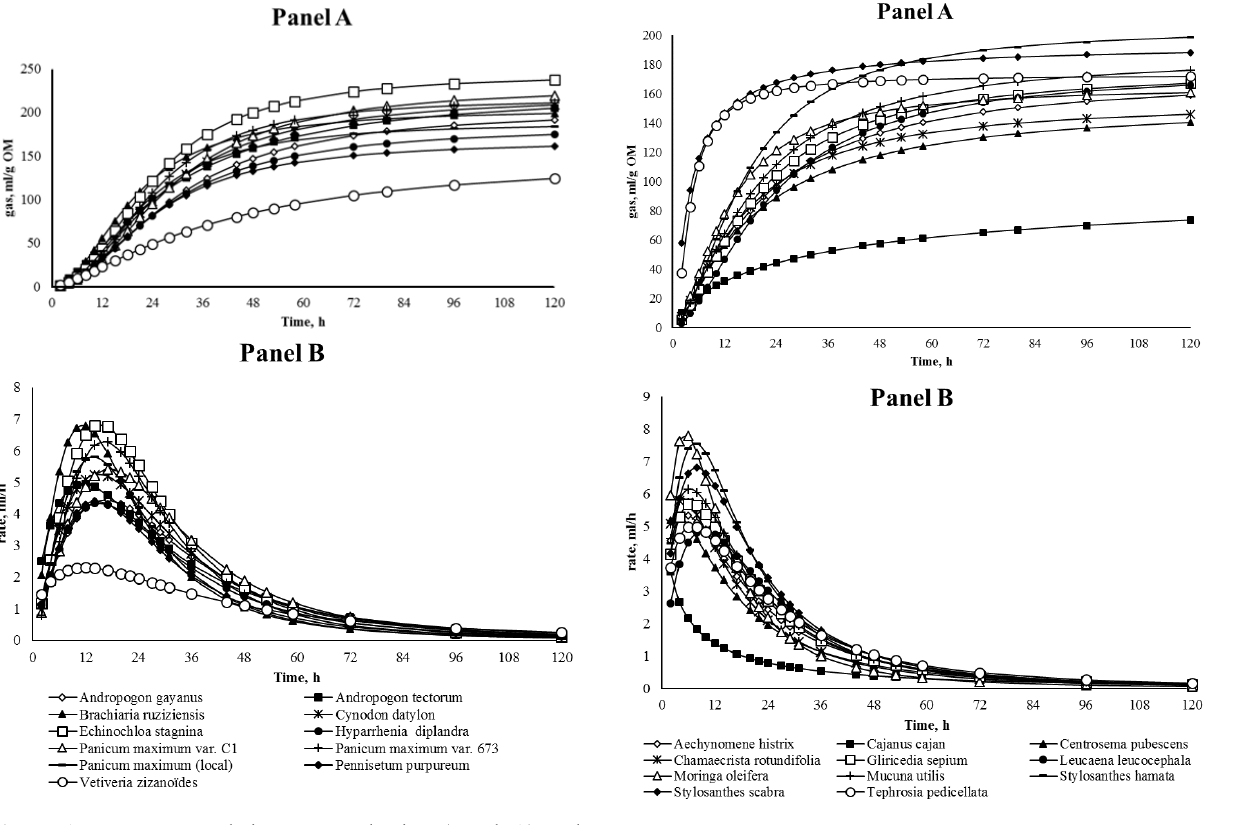
Figure 2. In vitro cumulative gas production (Panel A) and fermentation rate (Panel B) over time for